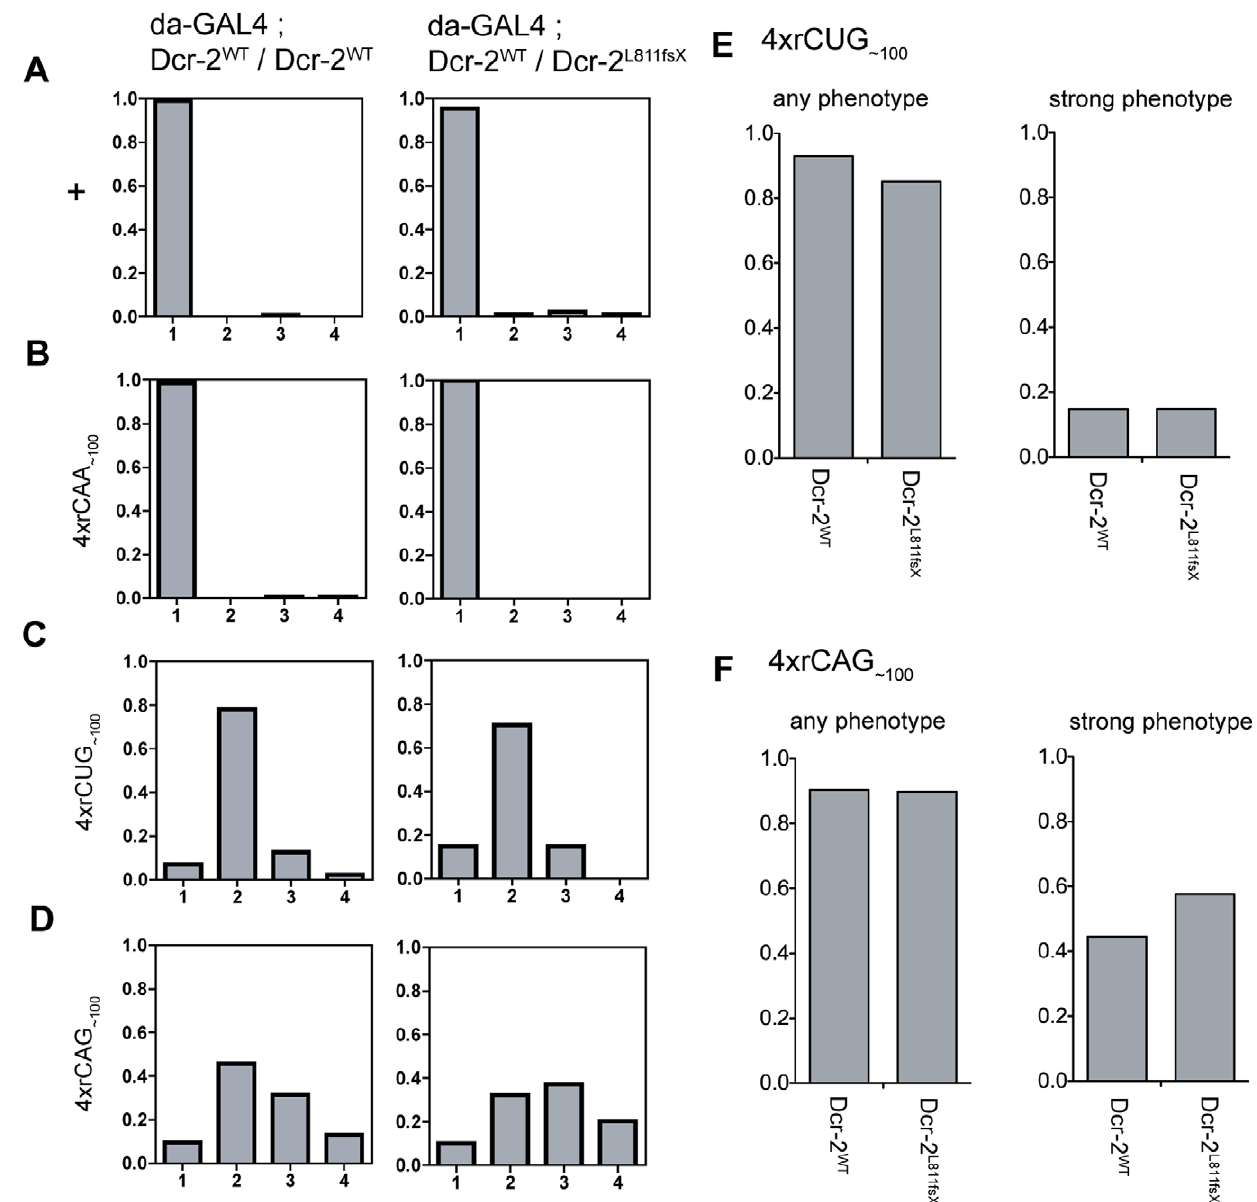
Figure 3. Reducing Dcr-2 levels is not rate limiting for the tergite phenotype. A-D , Proportion of progeny within each phenotype category when repeat expression is driven by da-GAL4 alone (left column), or in the presence of the Dcr-2 L811fsX mutant allele such that Dicer-2 levels are reduced (right column). A , Wild-type control, B , 4xrCAA , 100 [line 1] , C , 4xrCUG , 100 [line 1] , D , 4xrCAG , 100 [line 2] . E, F , Total proportion for each genotype that shows any phenotype (‘any phenotype’ - category 2, 3 and 4) and the proportion with a strong phenotype (‘strong phenotype’ – category 3 and 4). E , 4xrCUG , 100 [line 1] , F , 4xrCAG , 100 [line 2] . None of the observed changes were statistically significant (Fisher’s exact test).